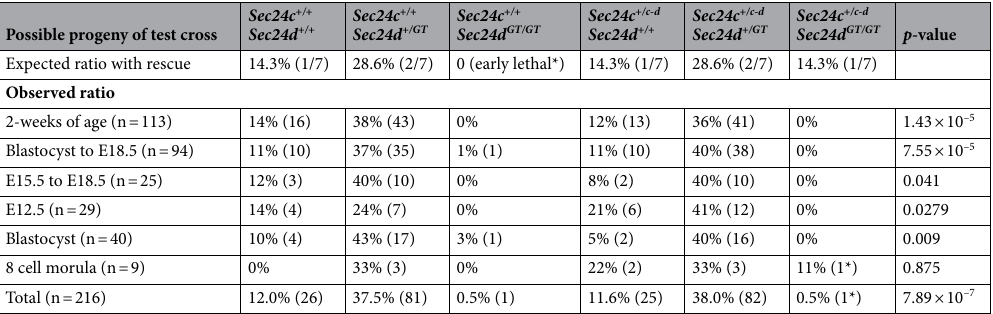
Table 2. Results of Sec24c + /c-d Sec24d + /GT x Sec24d + /GT intercrosses. For intercross data, p-values are calculated based on “others versus rescue” genotypes (6/7: 1/7). *Not considered a “rescue” because Sec24d GT/GT morulas have been reported previously 15